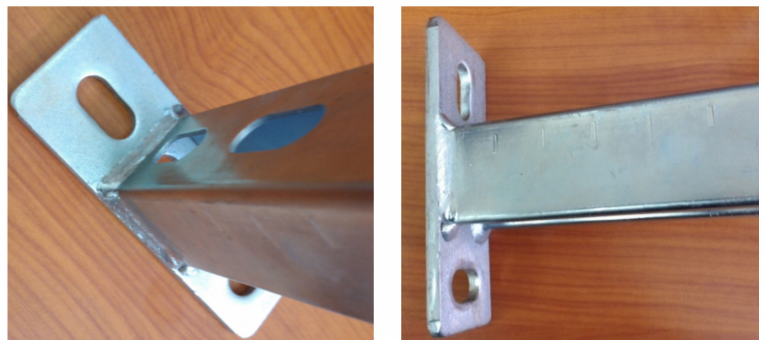
Figure 2. Example of a welded console—a close look at the weld zone after regalvanizing; standard profile of 40 mm × 40 mm cross-section